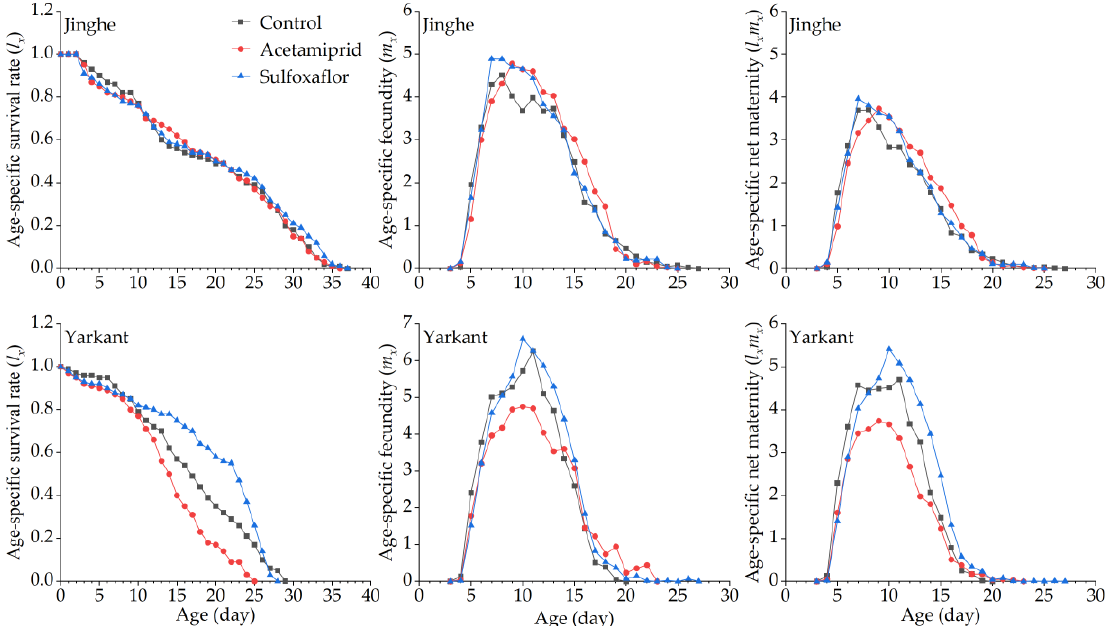
Figure 3. Effects of sublethal concentrations (LC 25 ) of acetamiprid and sulfoxaflor on the age-specific survival rate ( l x ), age-specific fecundity ( m x ), and age-specific maternity ( l x m x ) of A. gossypii of the F 1 generation in Yarkant and